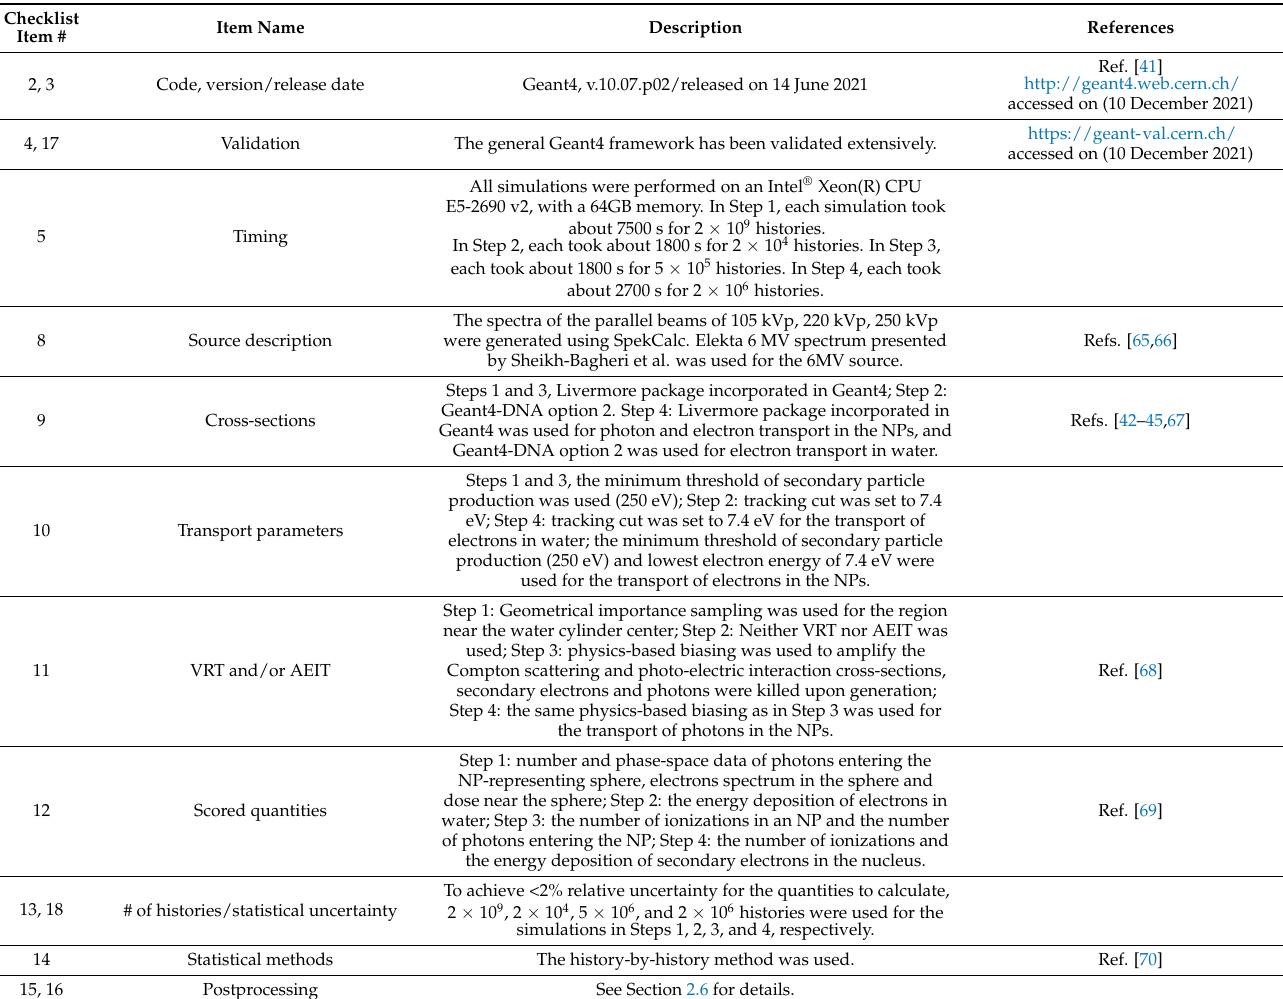
Table A1. Technical details of the MC simulations (the checklist item number is in line with TG 268